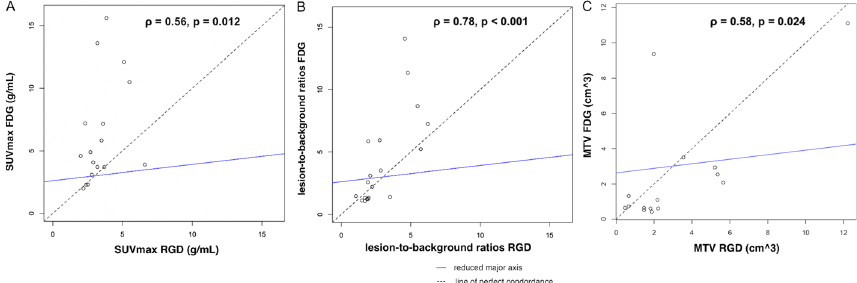
Fig. 3 Scatterplots showing positive correlation of SUV max ( A ), lesion-to-background ratios ( B ) and metabolic tumor volumes (MTV) ( C ) of 18 F-FDG and 68 Ga-NODAGA-RGD uptake on per-lesion